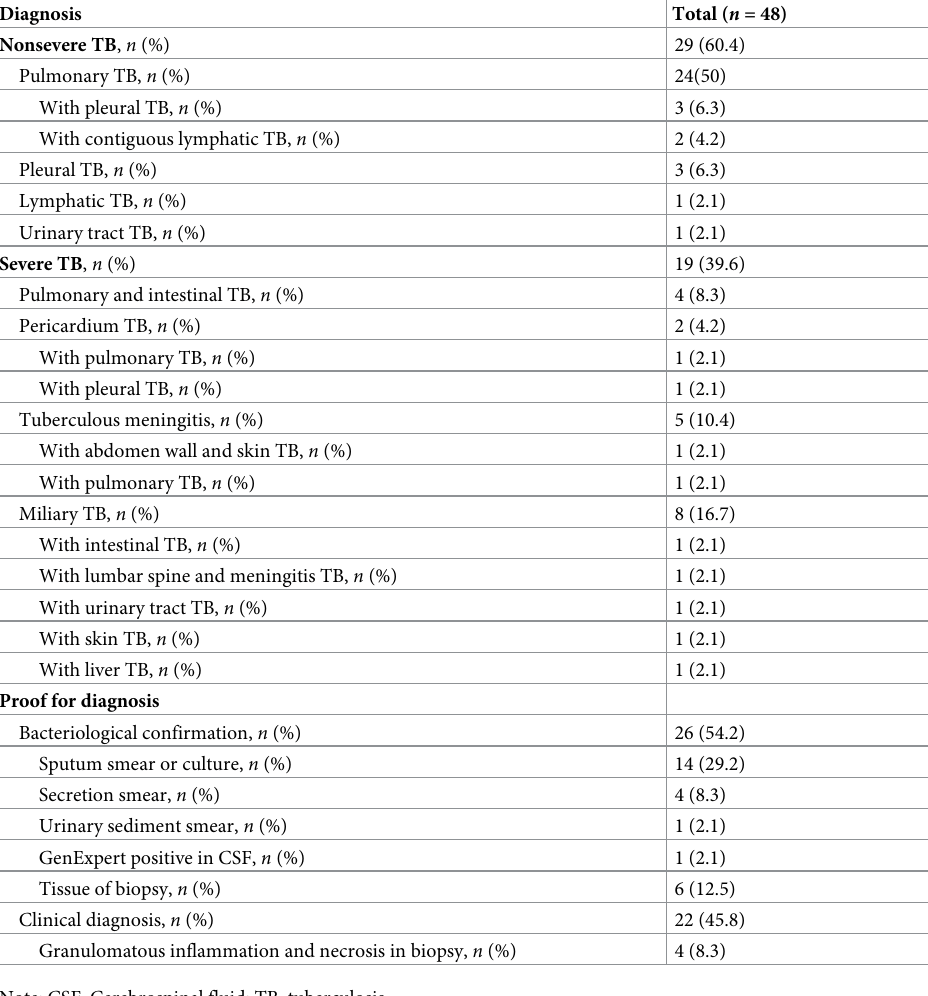
Table 2. Clinical diagnosis of 48 patients with active tuberculosis after transplantations.